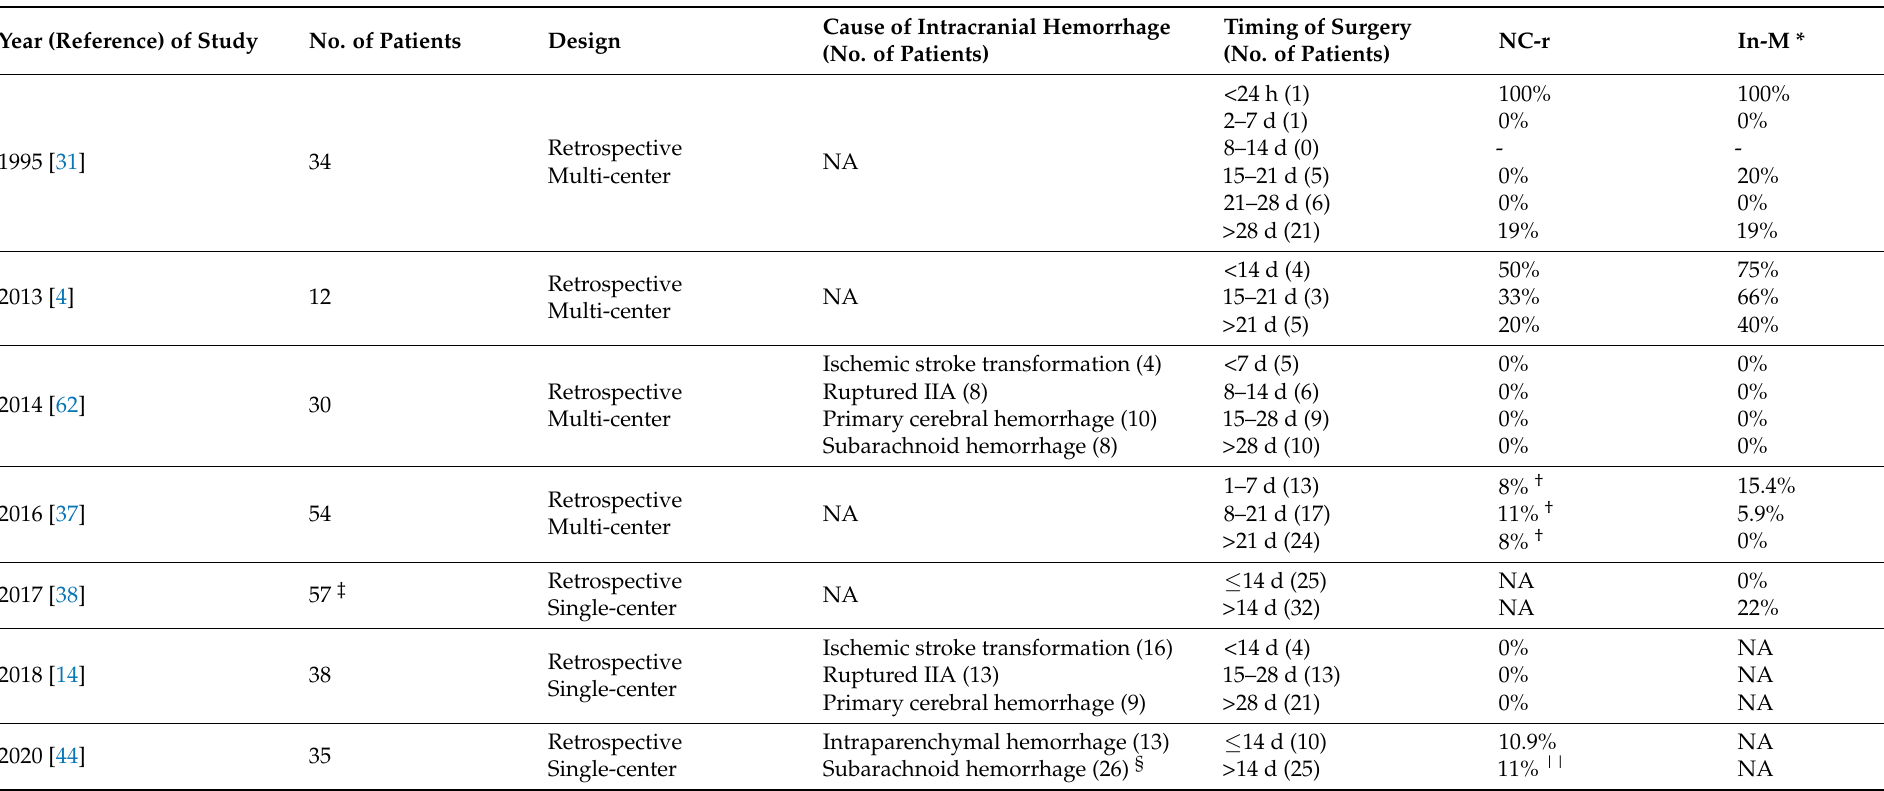
Table 2. Timing of cardiac surgery and outcomes reported in studies including patients with infective endocarditis and hemorrhagic neurological complication. Year (Reference) of Study No. of Patients Design